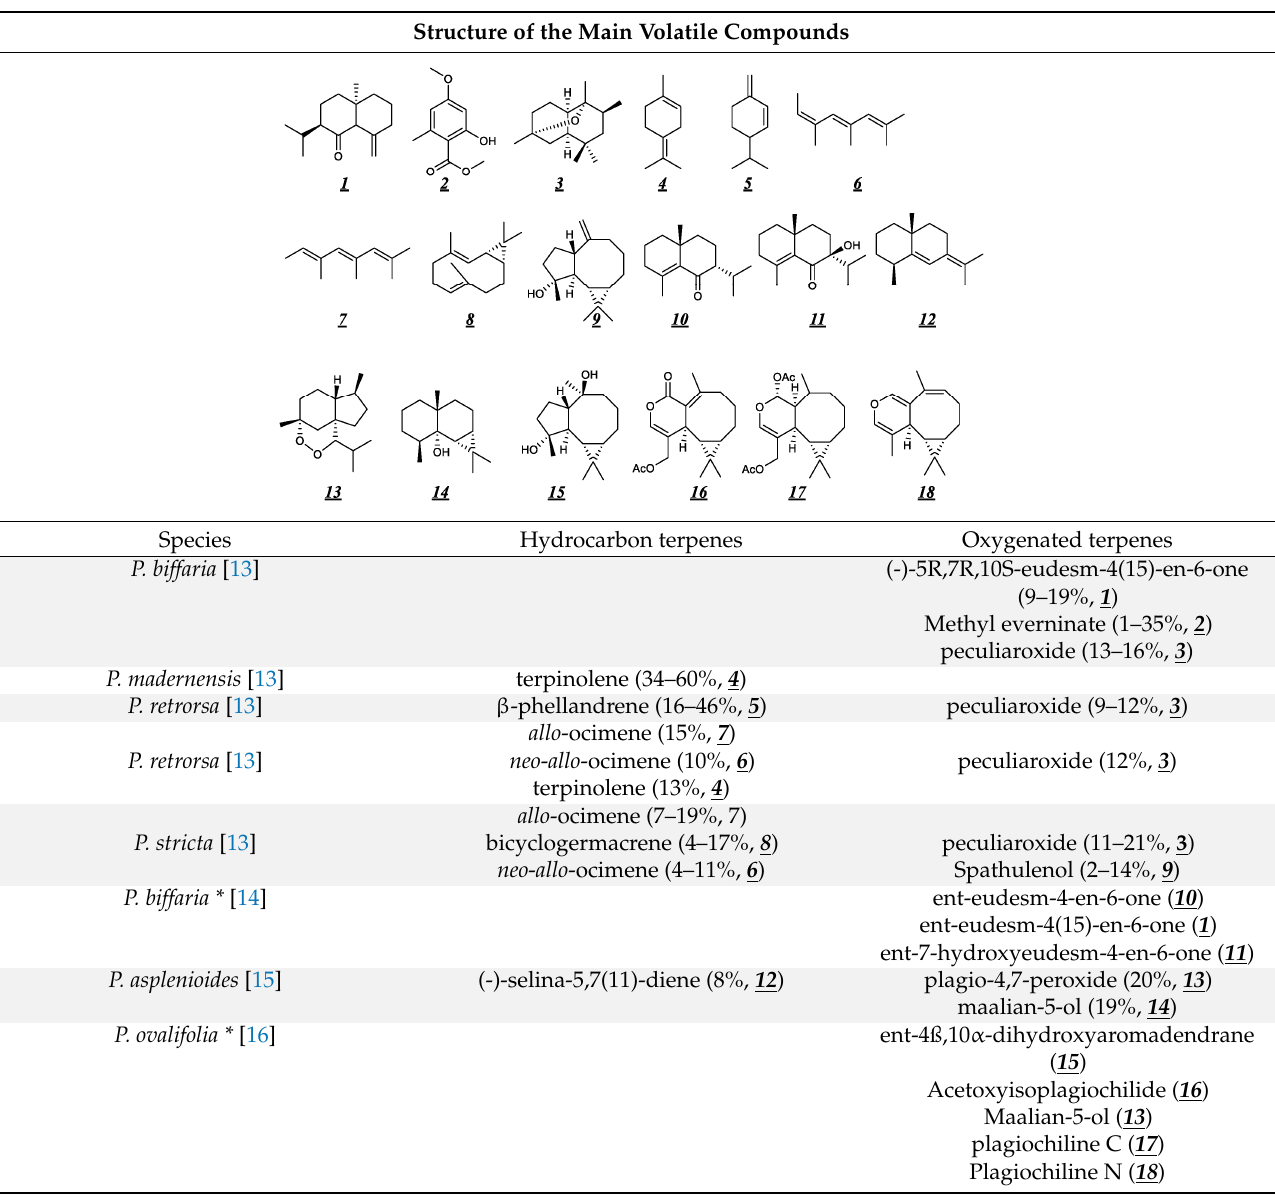
Table 1. Summary of principal volatile molecules reported for essential oils of different Plagiochila species [13–16].